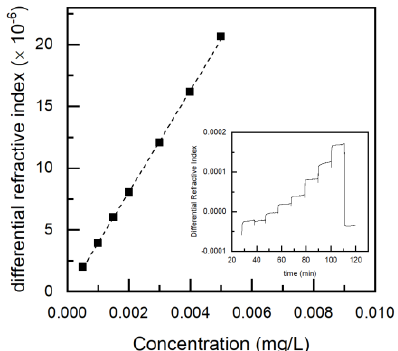
Figure 2. Specific refractive index increment ( ∂ n / ∂ c ) measurement of poly(2,3,4,5,6-pentafluorostyrene) (poly(PFS)). Sample: PFS / MMA-100; M w = 19.9 kg mol − 1 ; tetrahydrofuran (THF), 30 ◦ C, ( λ 0 ) = 690 nm; 0.5 mL min − 1 ; 0.1–5 mg mL − 1 . Inset) Di ff erential refractive index (dRI) of polymer dilution in THF, prior to solvent baseline subtraction of seven solutions of increasing concentrations against time. The initial and final steps represent the THF without polymer dissolved. Main figure dRI post baseline subtraction of poly(PFS) homopolymer solutions plotted against concentration. The slope of the data points (dotted line), determined by a linear fit, corresponds to the ∂ n / ∂ c of PFS in THF, at 30 ◦ C, under 690 nm wavelength). The instrumental standard deviation of each data point issmaller than the size of the data markers.